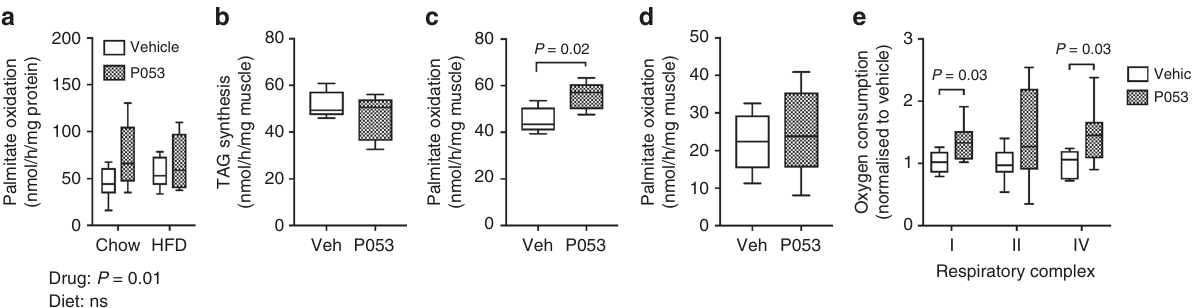
Fig. 5 CerS1 inhibition increases palmitate oxidation and mitochondrial respiratory capacity in SkM. a 14 C-palmitate oxidation in SkM homogenates from mice treated for 6 weeks with P053 or vehicle ( n = 10 mice). b 14 C-palmitate incorporation into TAG, and c 14 C-palmitate oxidation, in isolated soleus muscles taken from mice treated for two weeks with 5 mg/kg P053 or vehicle control ( n = 5 mice). Results show nmoles 14 C-palmitate converted to b TAG or c CO 2 + acid soluble metabolites. d Palmitate oxidation in soleus muscle strips pre-treated for 1.5 h in vitro with 1 μ M P053 or vehicle control ( n = 5 mice). e ADP-stimulated (State 3) respiratory complex activities measured in permeabilised extensor digitorum longus muscle fi bres of mice treated for three weeks with 5 mg/kg P053 or vehicle control ( n = 7 mice). Statistical signi fi cance in ( a ) was determined by two-way ANOVA (main effect of drug and diet reported below the graph), and in ( b – e ) by two-tailed t -tests (results where P < 0.05 are indicated on